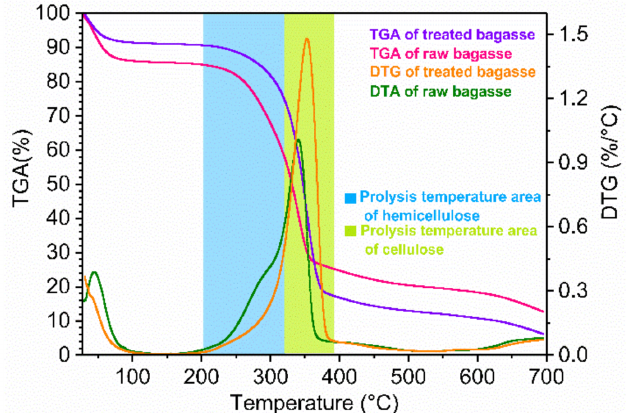
Figure 6. Thermal gravity analysis (TGA) and differential thermogravimetry (DTG) of the raw and pretreated bagasse fibers (120 ◦ C, 10 min, 1:50, 0.4 mol/L oxalic